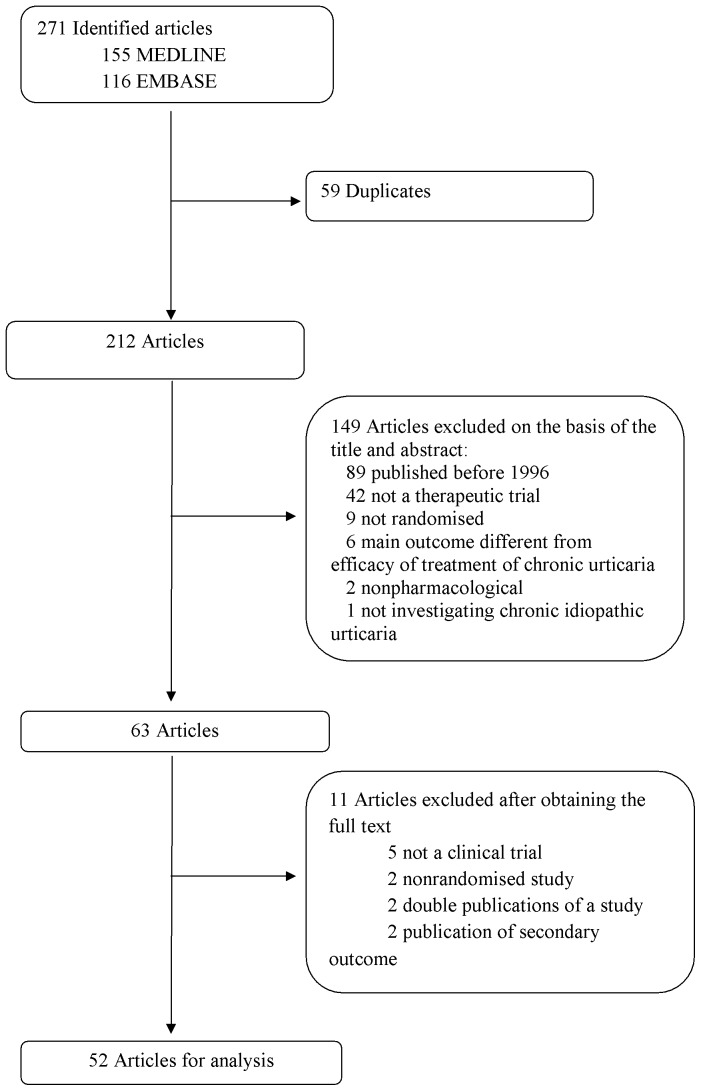
Flow diagram of selected papers.